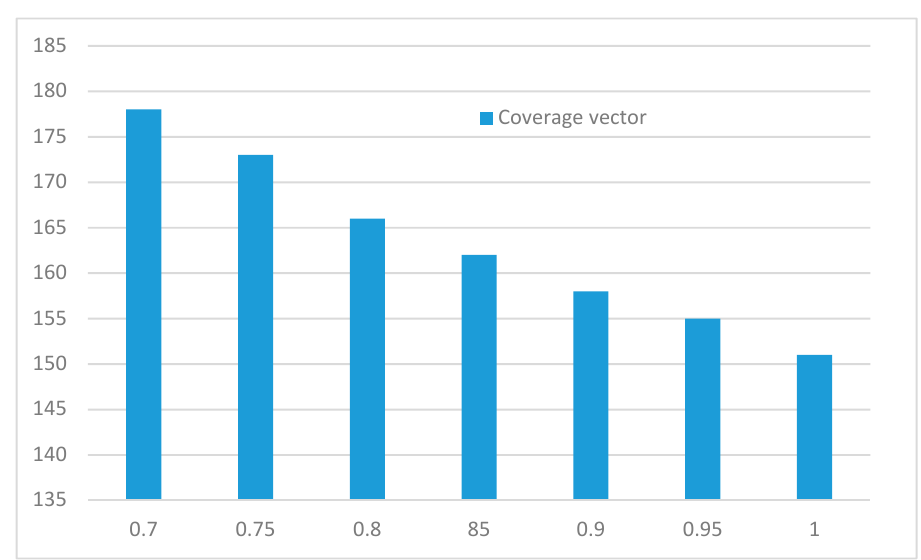
Figure 11. Relationship of coverage vector and network lifetime.